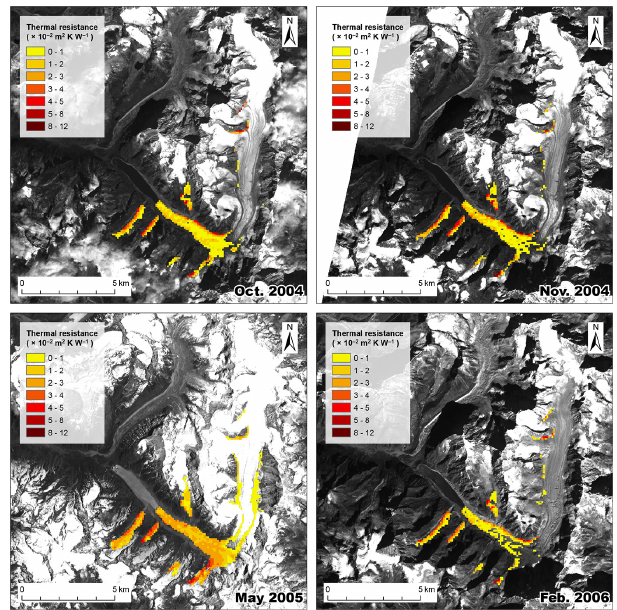
Figure 4. Distributions of thermal resistance for individual ASTER scenes on the Trambau Glacier, which we used to generate the av- eraged thermal resistance for the calculations (Fig. 1b).